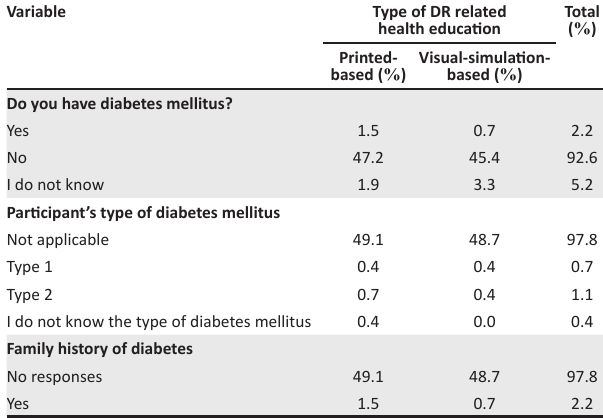
TABLE 2: Diabetic profile of study participants.